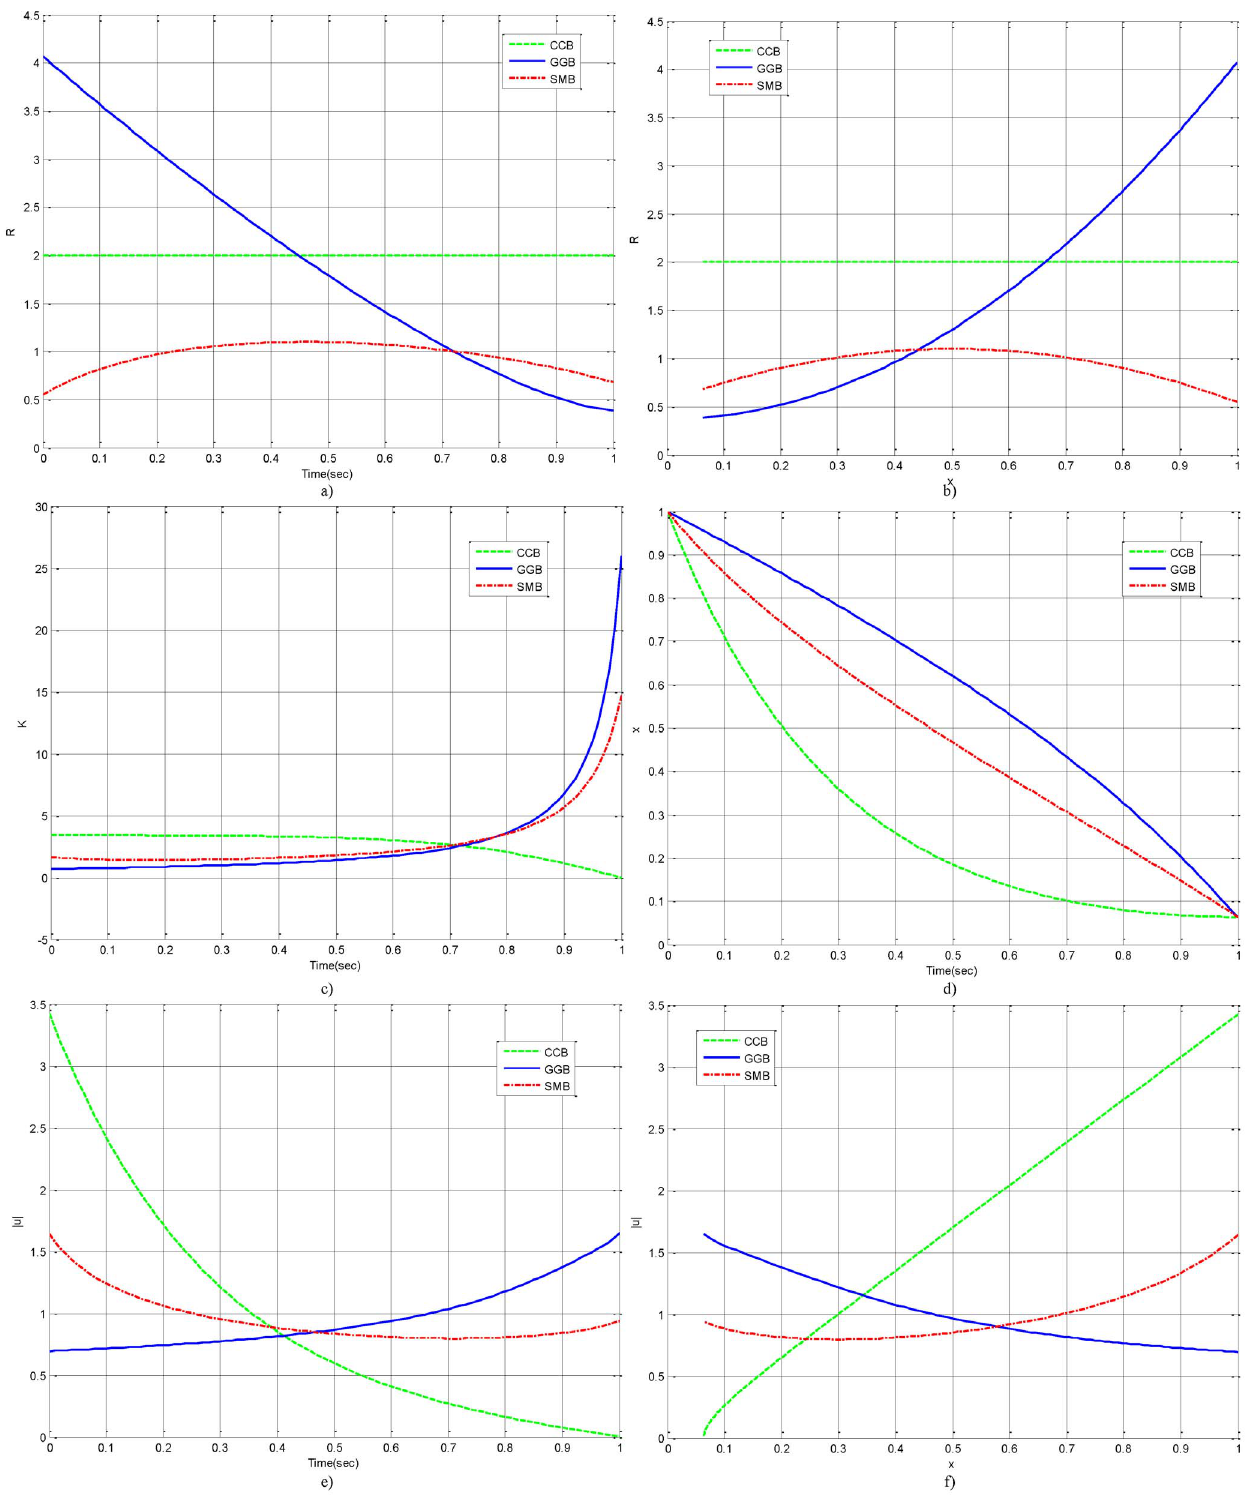
Figure 4. Three Goal Pursuit Behaviors: a) Control Energy Penalty R vs. Time; b) Control Energy Penalty R vs. Goal Discrepancy x; c) Feedback Gain K; d) Goal Discrepancy x; e) Control Effort u vs. Time; f) Control Effort u vs. Goal Discrepancy x.